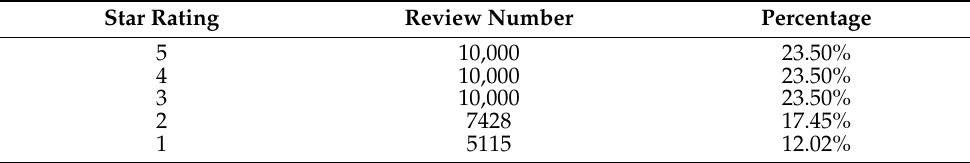
Table 3. Statistics of the stars in